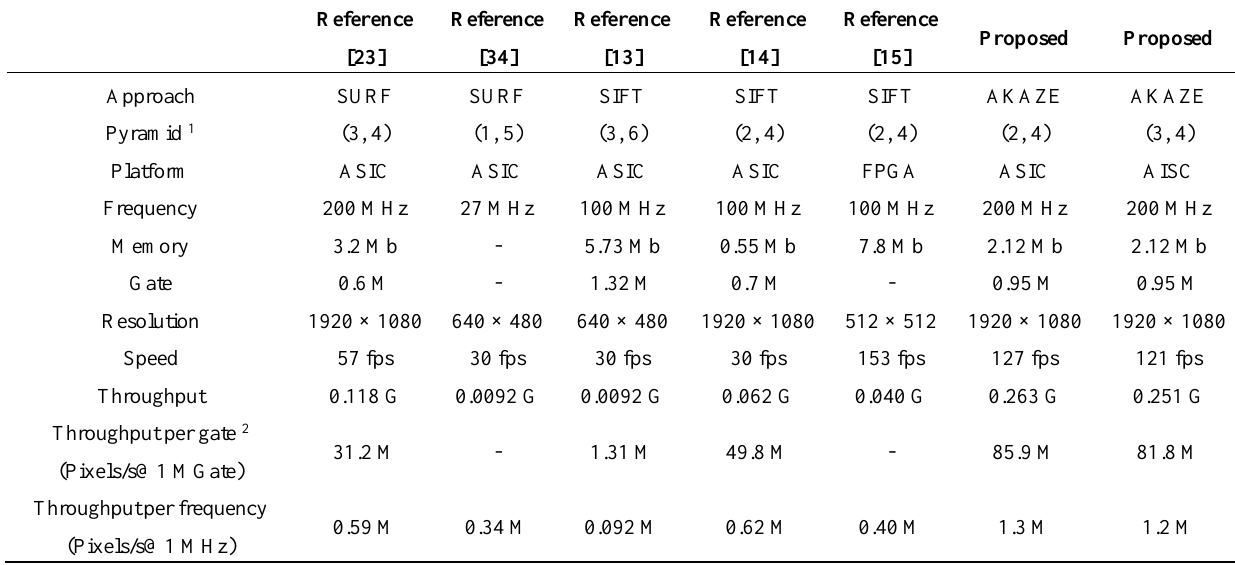
Figure 13. Layout of the proposed AKAZE accelerator. Table 3. Comparison of performance.